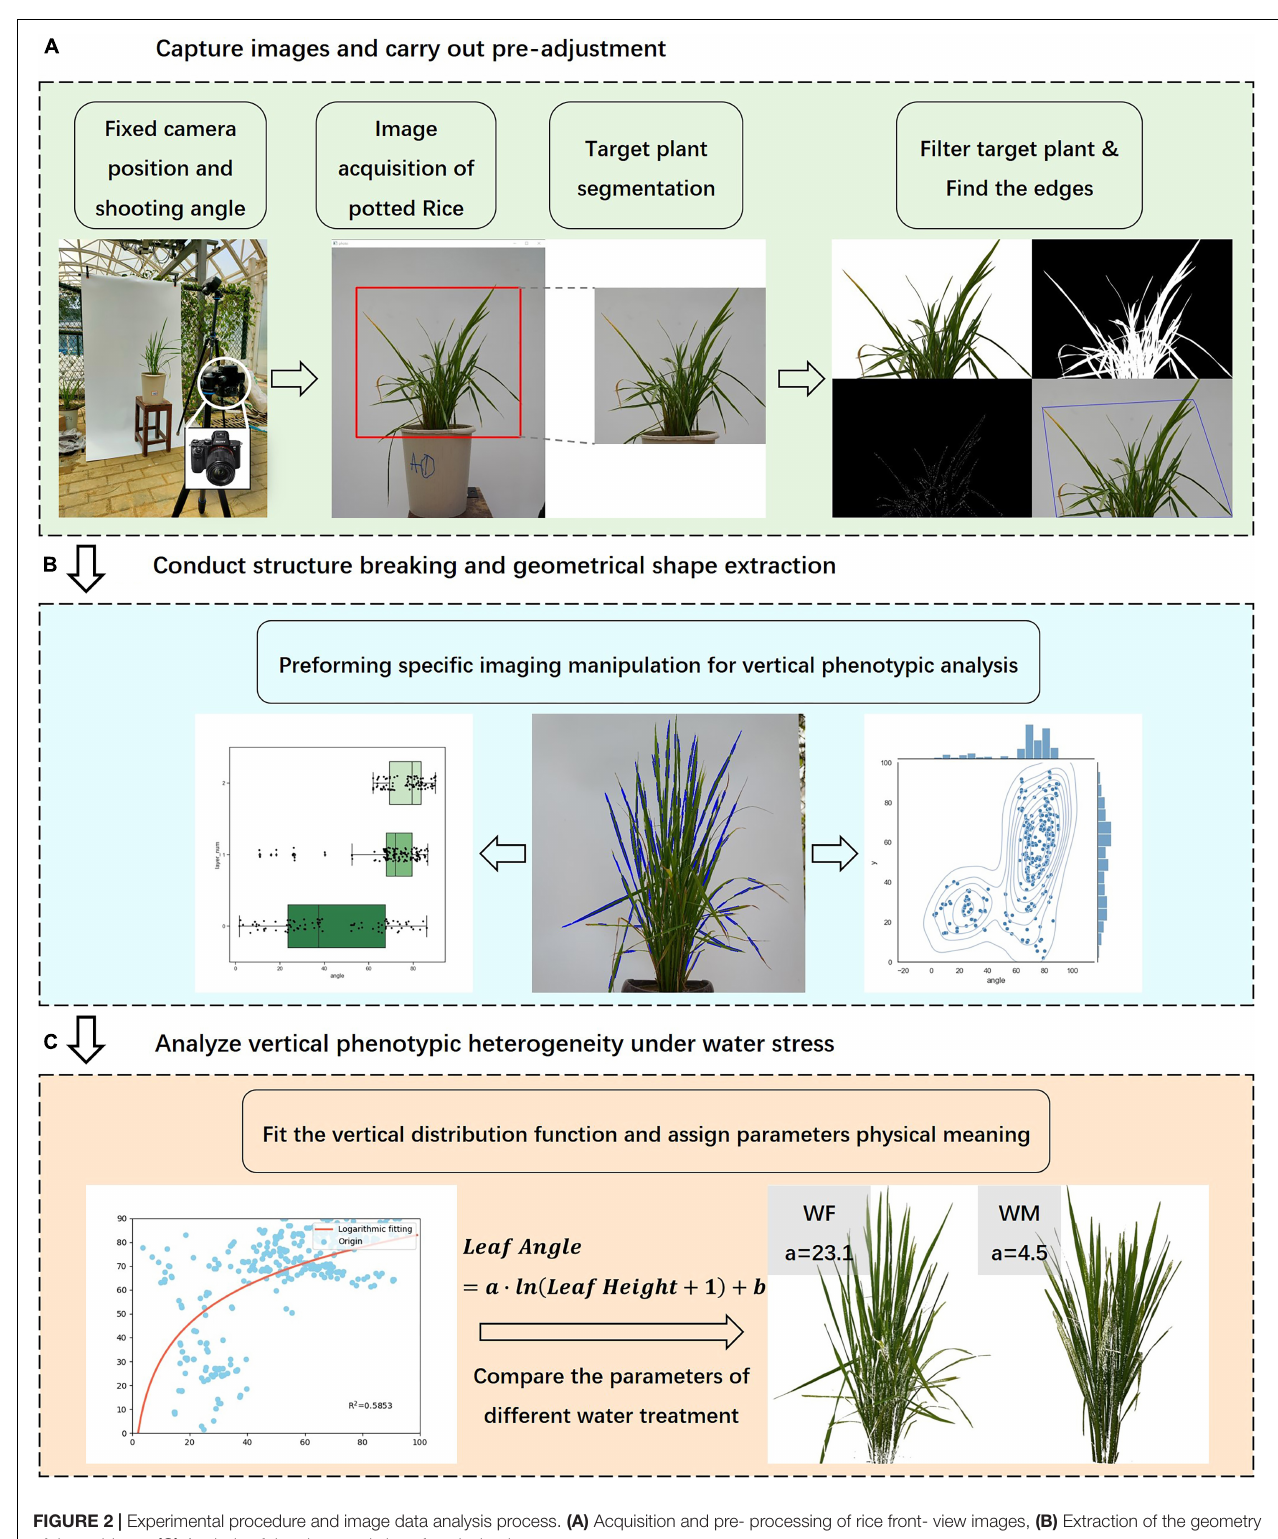
FIGURE 2 | Experimental procedure and image data analysis process. (A) Acquisition and pre- processing of rice front- view images, (B) Extraction of the geometry of rice subjects, (C) Analysis of the characteristics of vertical traits.